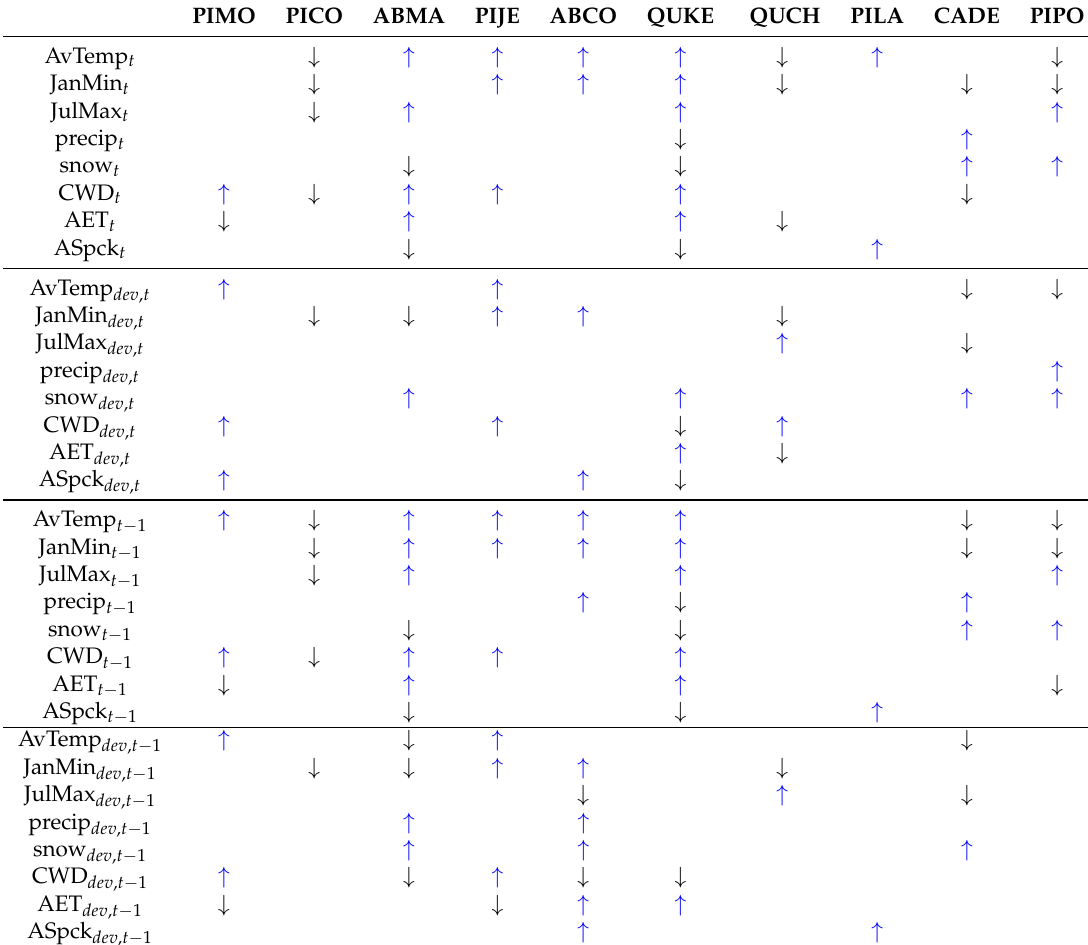
Table 5. Effect of the climate variable on tree growth. ↓ when the 95% confidence interval of the parameter is negative, ↑ when the 95% confidence interval of the parameter is positive, and nothing when 0 is in the 95% confidence interval of the parameter. PIMO PICO ABMA PIJE ABCO QUKE QUCH PILA CADE PIPO